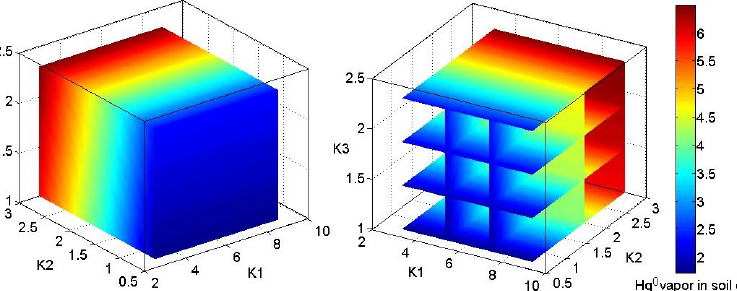
Figure 2. Variation of Hg 0 concentrations (ngm − 3 ) in the forest soil pore gas using the typical ranges of kinetic constants for Hg II re- duction in soil (see text for details): k 1 = 3 . 0–9 . 0 × 10 − 9 m 2 W − 1 s − 1 , k 2 = 0 . 7–3 . 0 × 10 − 3 m 2 W − 1 h − 1 , k 3 = 1 . 0–2 . 3 × 10 − 3 h − 1 , soil Hg content = 150ngg − 1 , pH = 4, soil organic content = 20%, soil bulk density = 0.8gm − 3 , solar irradiance = 1000Wm − 2 , soil tempera- ture = 25 ◦ C, LAI = 5m 2 m − 2 , soil moisture content = 20%, and soil porosity = 40%. The environmental conditions are similar to condi- tions reported by Moore and Castro